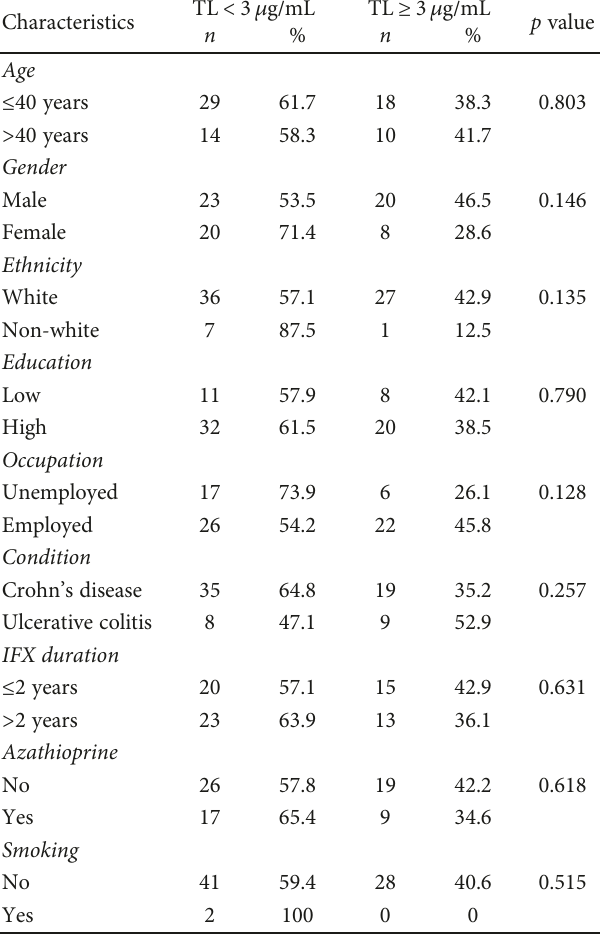
Table 1: Patients ’ main characteristics according to in fl iximab